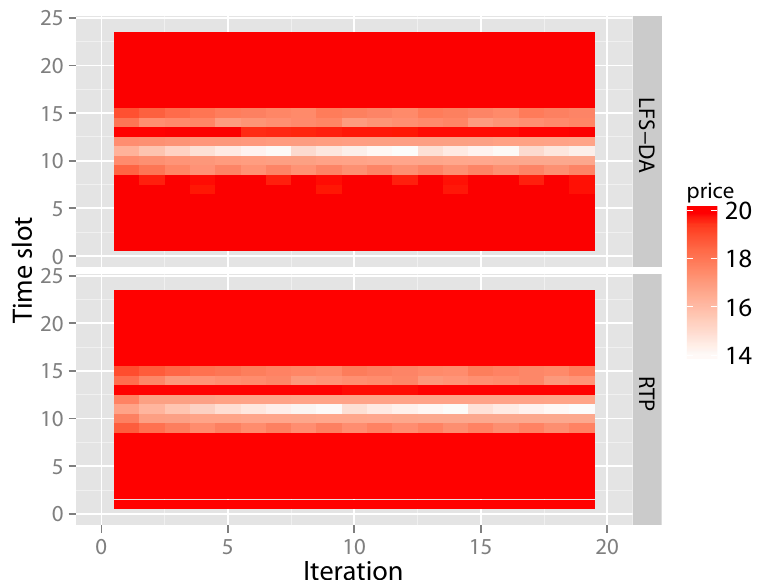
Figure 6. Price profiles determined by iteration with LFS-DA and with RTP.